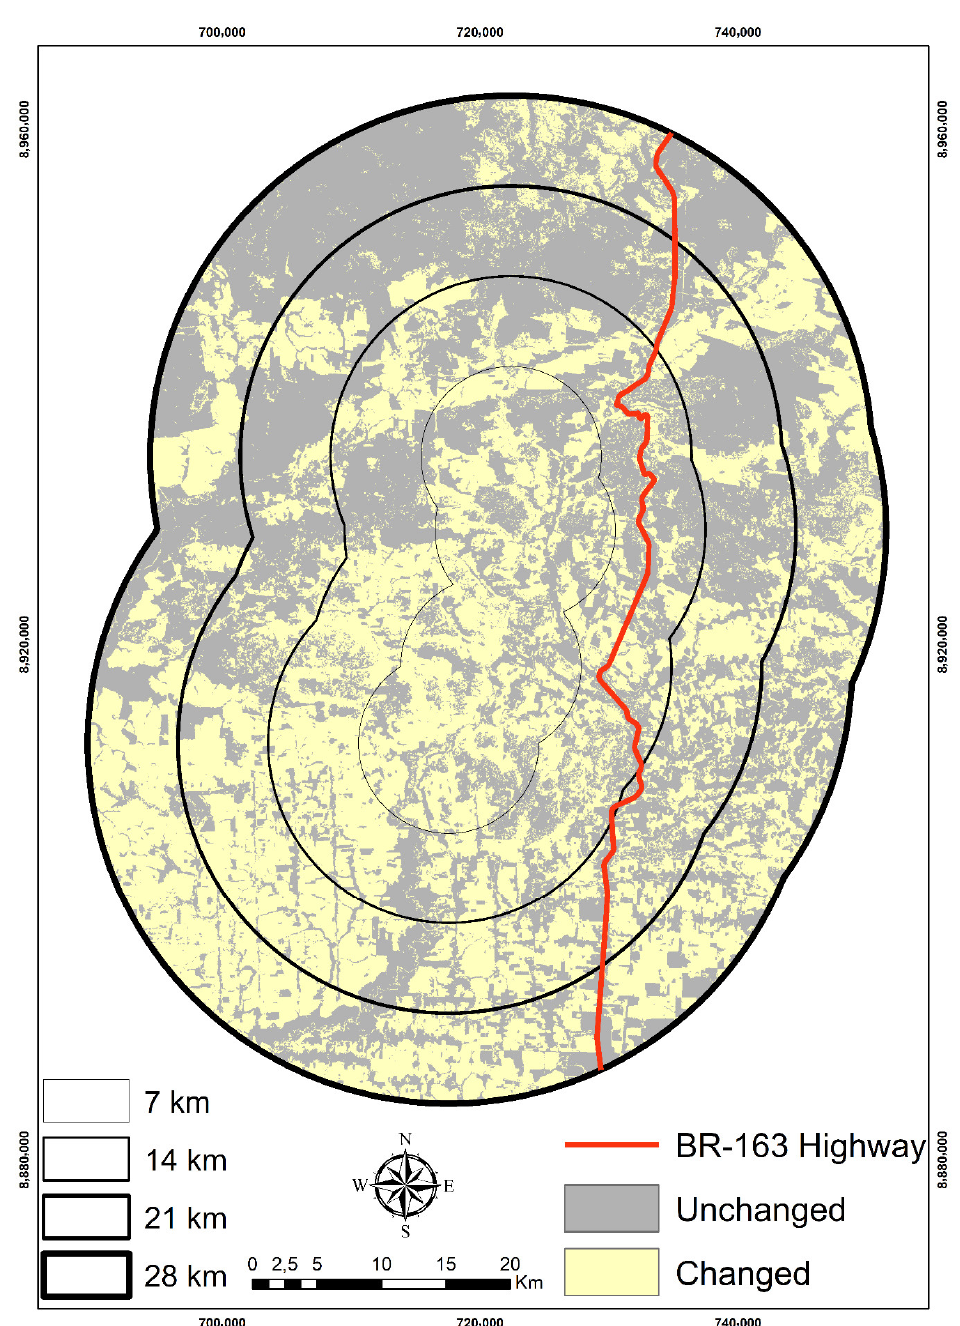
Figure 4. Map showing whether changes have occurred in land use and land cover in the direct influence zone of the Braço Norte Hydropower Complex (7 km buffer), and in the influence expansion zone (14 km, 21 km, and 28 km buffers) between 1985 and 2018. Source: MapBiomas-Collection 4.1 level 3 dataset [25] .